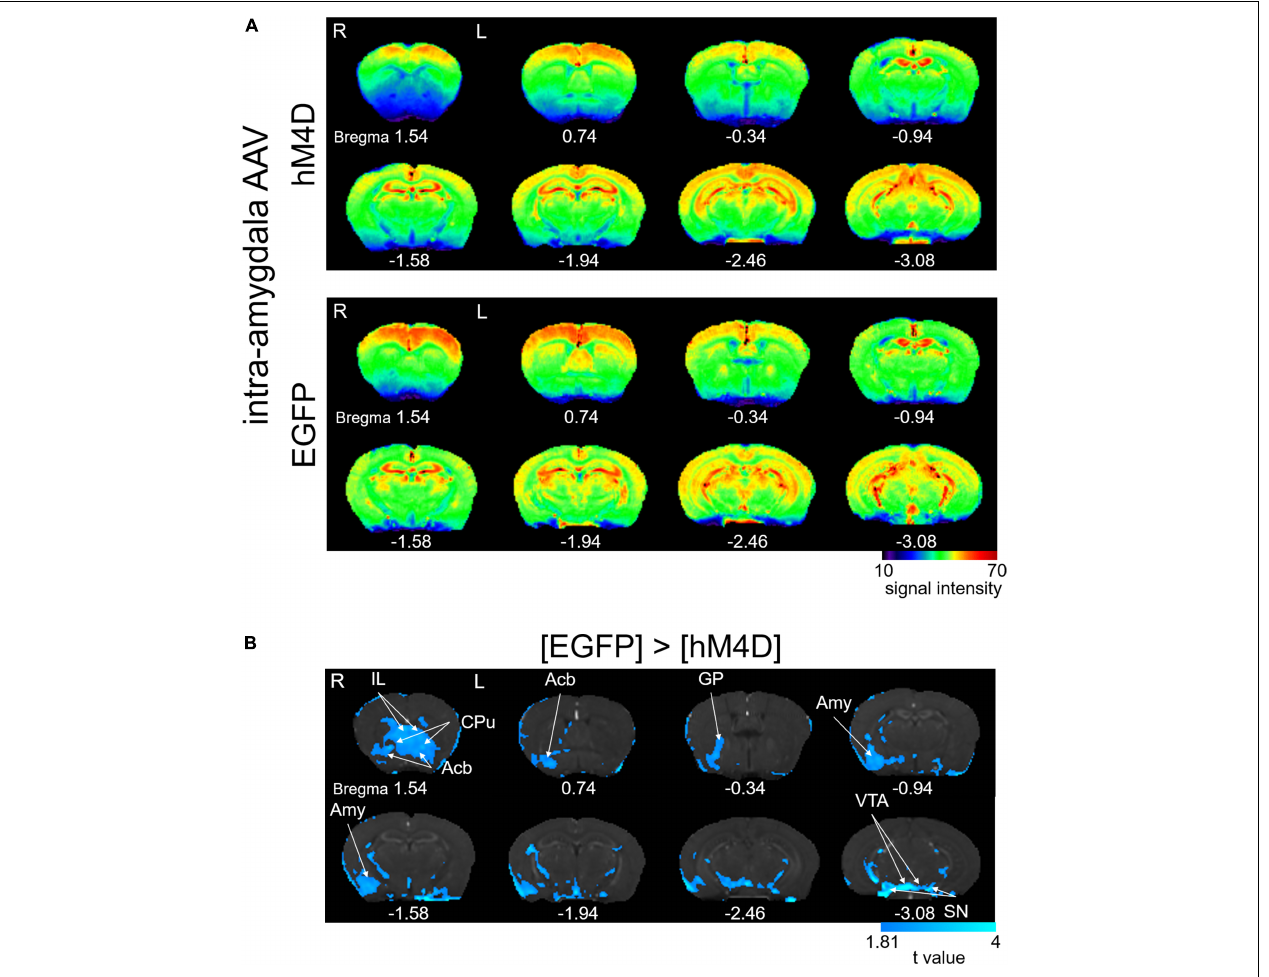
FIGURE 3 | Effects of repeated activation of hM4D receptors expressed in the right amygdala on manganese accumulation. (A) Color map display of averaged T1-weighted images in [hM4D] and [EGFP]. R, the right side; L, the left side (for all panels in this figure). The color bar indicates normalized signal intensity. The numbers below the images indicate the anterior-posterior coordinate from bregma. (B) Comparisons of the signal intensity between [hM4D] and [EGFP] shown as t -value plots ( P < 0.05, cluster-wise FDR corrected). IL, infralimbic cortex; Acb, nucleus accumbens; GP, globus pallidus; Amy, amygdala; VTA, ventral tegmental area; SN, substantia nigra. The color bar indicates the t -value (the signals with [hM4D] were significantly smaller than those with